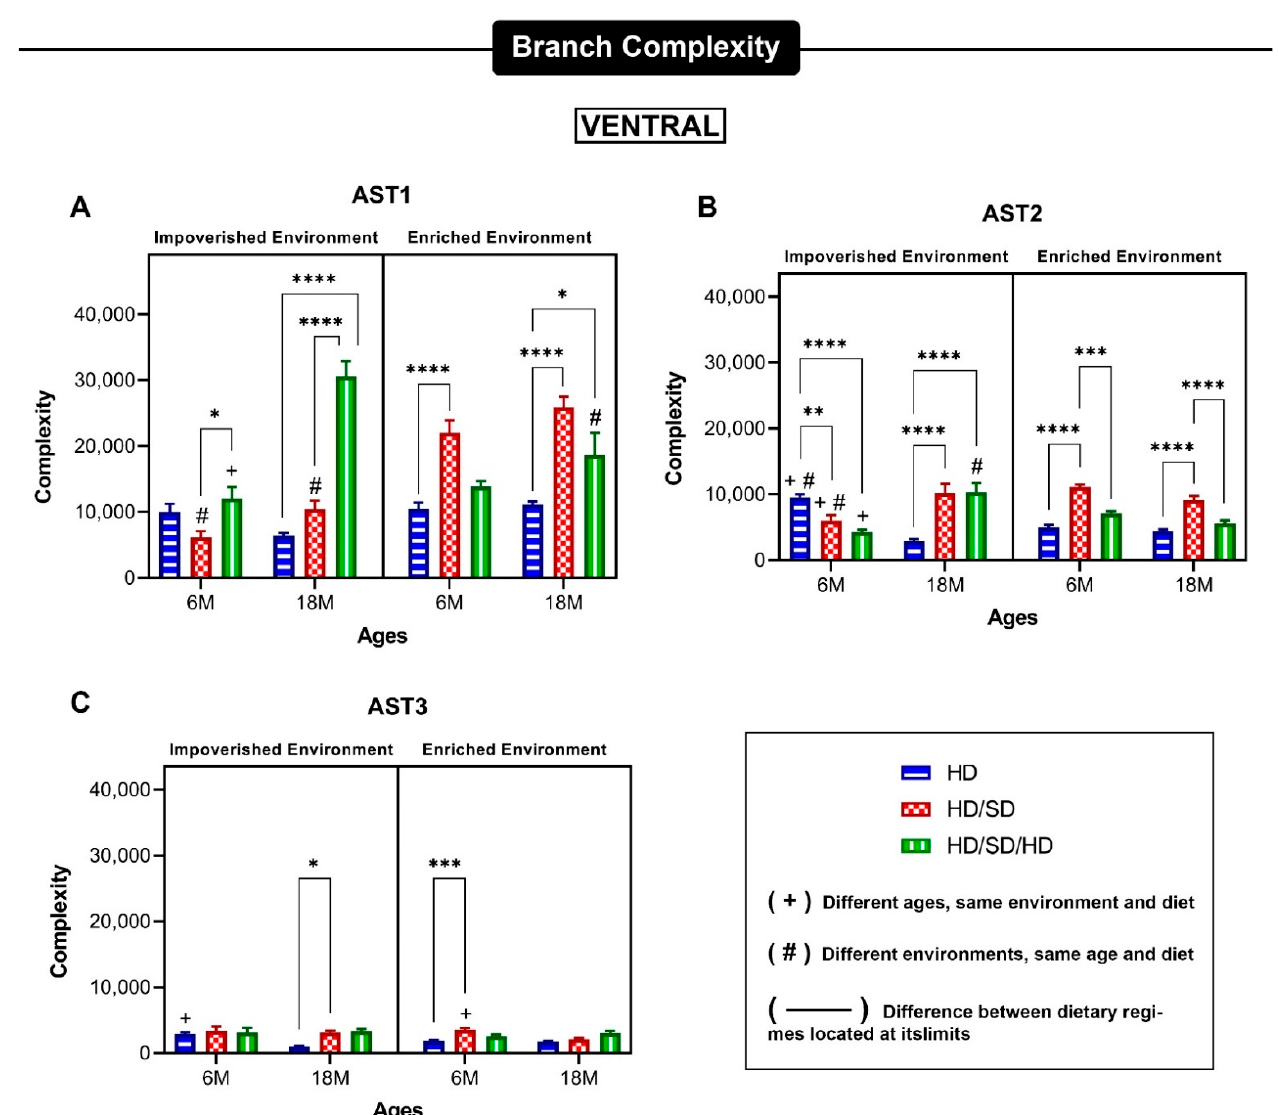
Figure 7. Mean values of morphological complexity for astrocytes morphological phenotypes from the external one-third of the molecular layer of the ventral dentate gyrus. ( A – C ): Mean values of branch complexity and corresponding standard errors of astrocyte arbors to illustrate morphological differences between AST1 ( A ), AST2 ( B ) and AST 3 ( C ) for each experimental group based on impoverished environment and enriched environment, age (6M—6-month-old; 18M—18-month-old) and masticatory regimen (HD, HD/SD, and HD/SD/HD). Asterisk (*) over connector bars denotes statistically significant difference (*) = p < 0.05; (**) = p < 0.01; (***) = p < 0.001; (****) = p < 0.0001.